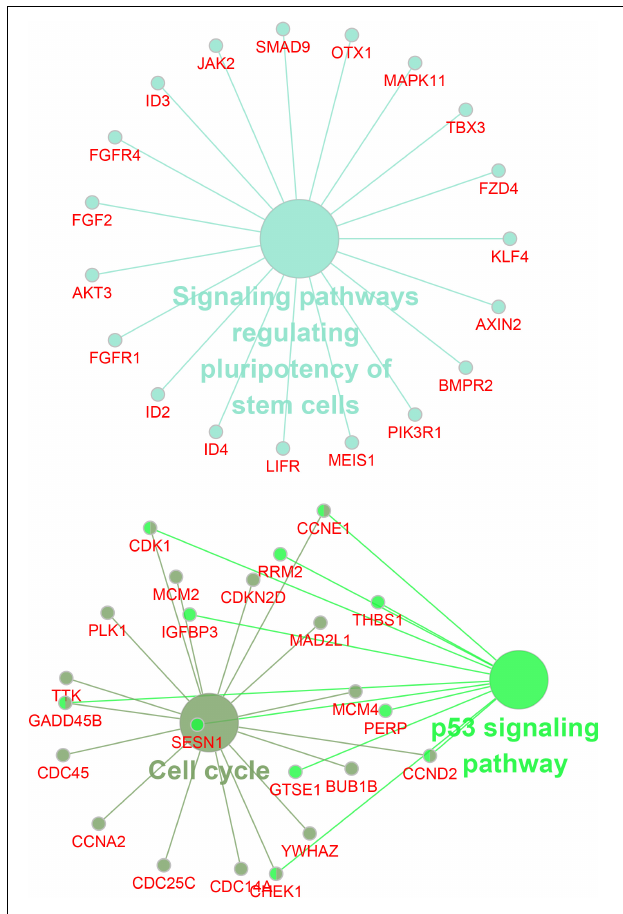
FIGURE 4 | Bioinformatics analysis of circDENND2A associated ceRNA network. CircDENND2A associated ceRNA networks included 39 miRNAs and 867 differently expressed mRNAs. Purple node, circDENND2A; yellow nodes, miRNAs; blue nodes, mRNAs. ceRNA, competing endogenous RNA; miRNA,